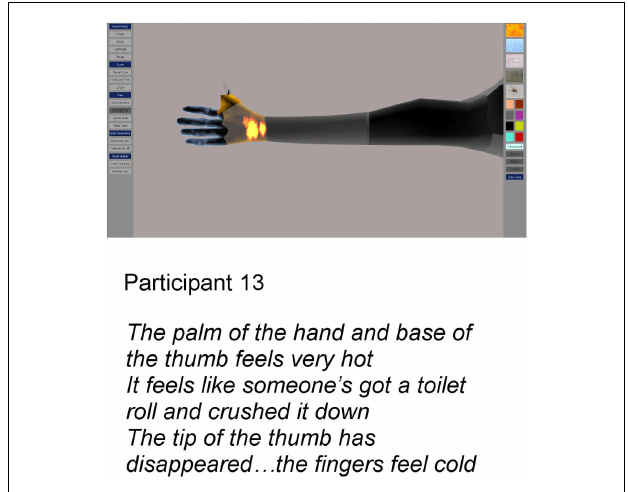
FIGURE 4 | Image produced after additional features were added to the application: particle texture effects and fractionation of digits